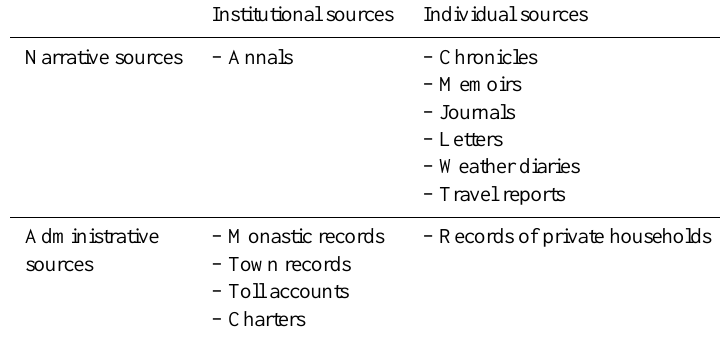
Table 1. Classification of documentary sources (Pfister et al., 2009; Camenisch,